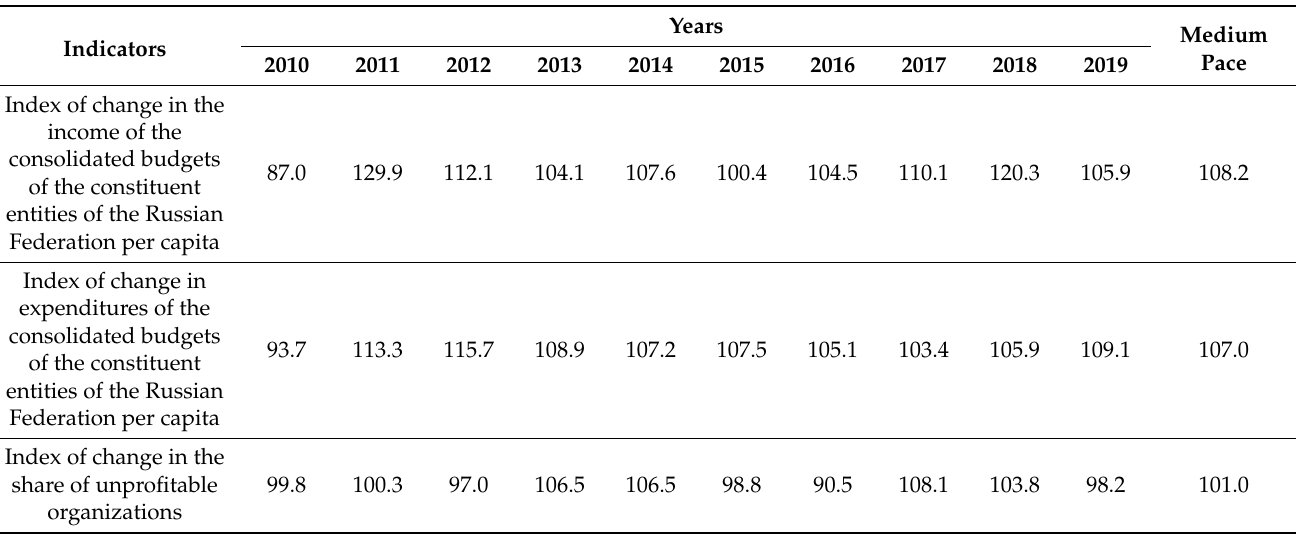
Table 14. Dynamics of changes in indicators characterizing the macro-regional block “Finance” in the Russian Federation in 2010–2019, in % of the previous year.